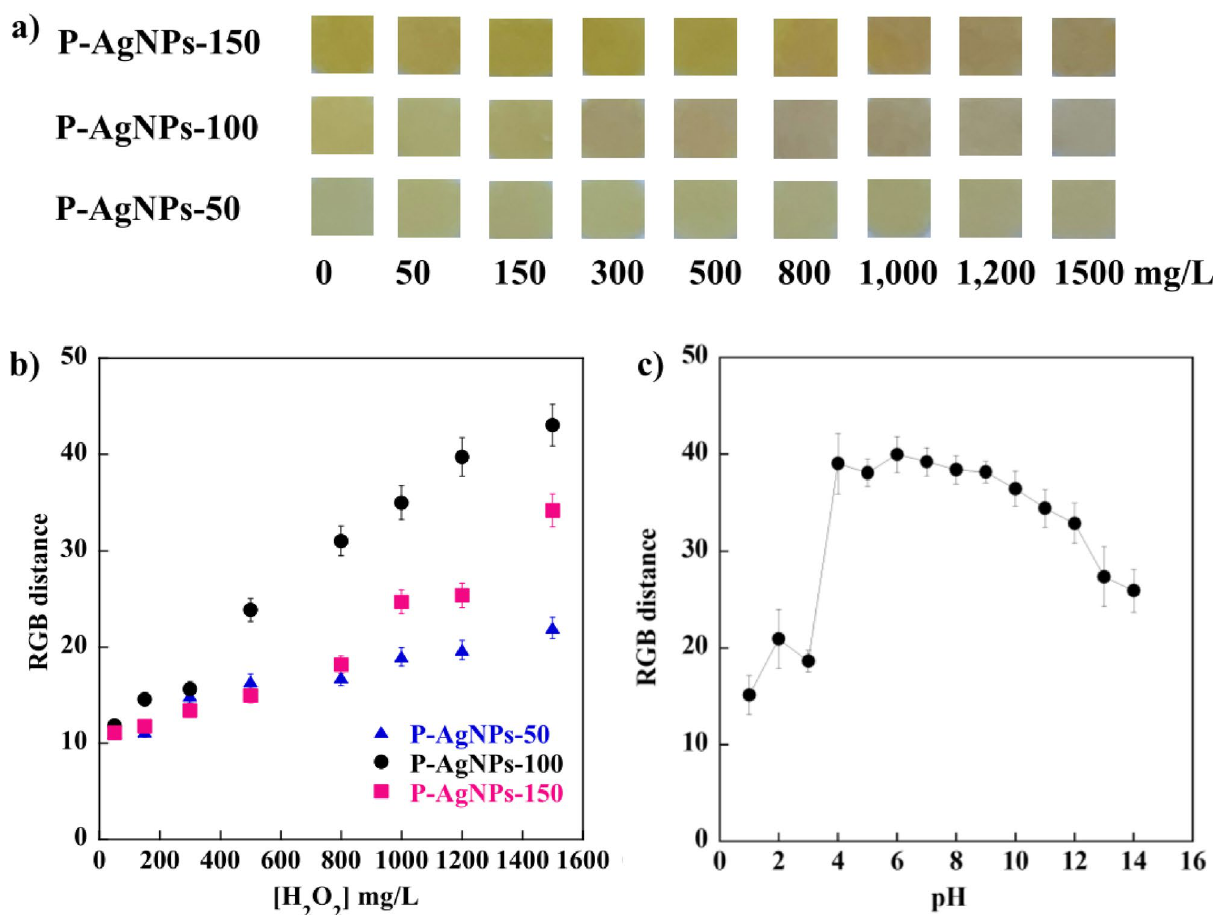
Figure 6. ( a ) Digital images of the test P-AgNPs in the presence of different H 2 O 2 concentrations, ( b ) analytical curves for H 2 O 2 detection by P-AgNPs, and ( c ) analytical curves for H 2 O 2 detection by P-AgNPs-100 at different pH H O responsiveness of P‑AgNPs‑100. The colorimetric sensing capability of P-AgNPs-100 for H 2 2 was determined, as illustrated in Fig. 7. After the H 2 O 2 solution was deposited on P-AgNPs-100, color change with different shades depending on the H 2 O 2 concentration was detected, which was attributed to the destruc- tion of P-AgNPs-100 by the oxidation capability of H 2 O 2 . The AgNPs were oxidized to silver ions 54 . The possible reaction mechanism of AgNPs and H 2 O 2 is expressed as Eq. (3):